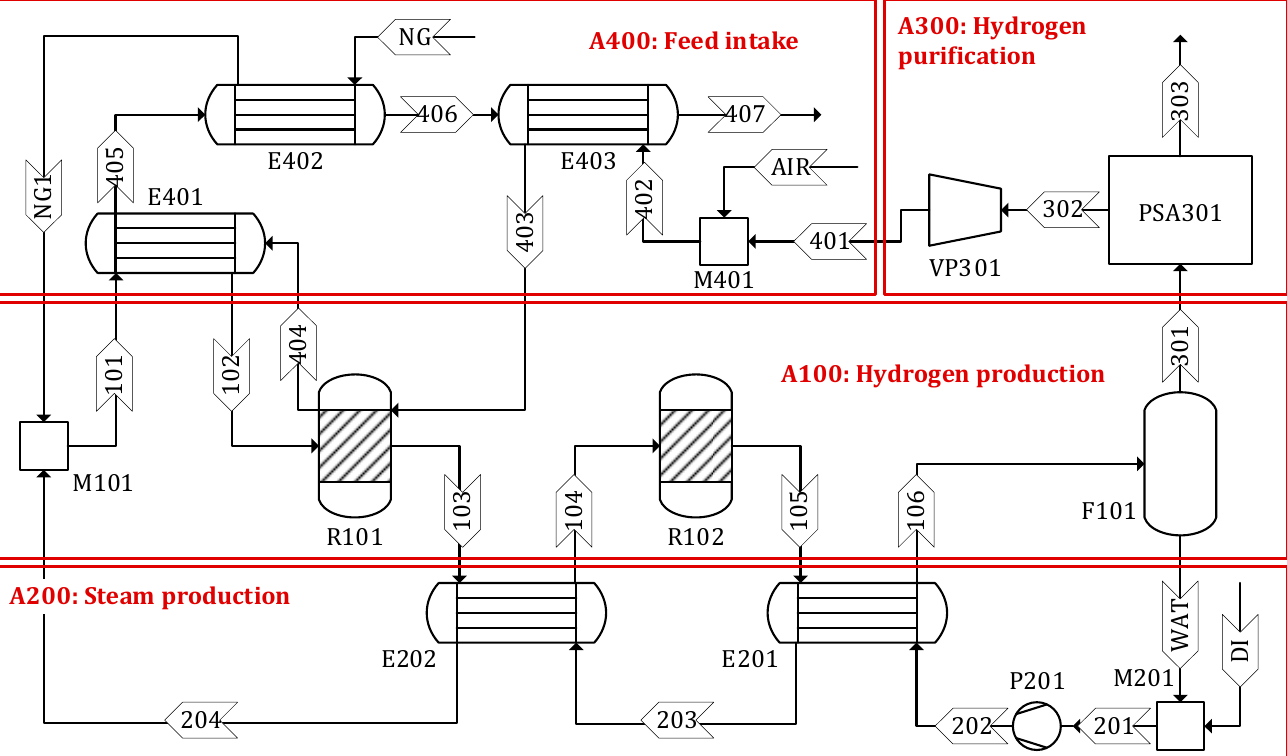
Figure 2. Process flow diagram of steam methane reforming.